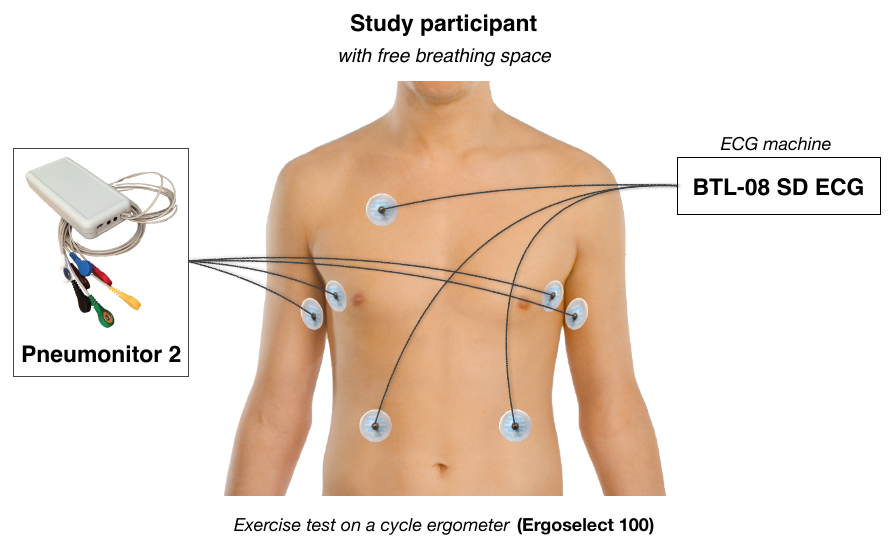
Figure 1. The scheme of the configuration of measurement equipment and